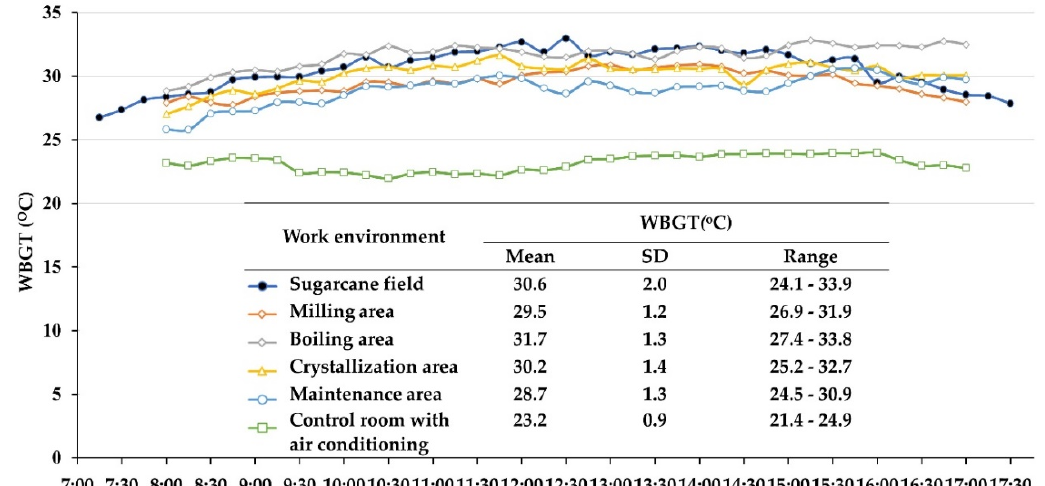
Figure 1. Mean of wet bulb globe temperature (WBGT) in work environments of sugarcane workers in the hottest month of the harvesting season (n = 3 measurements). Table 3. Classification of workload and heat exposure for sugarcane workers.